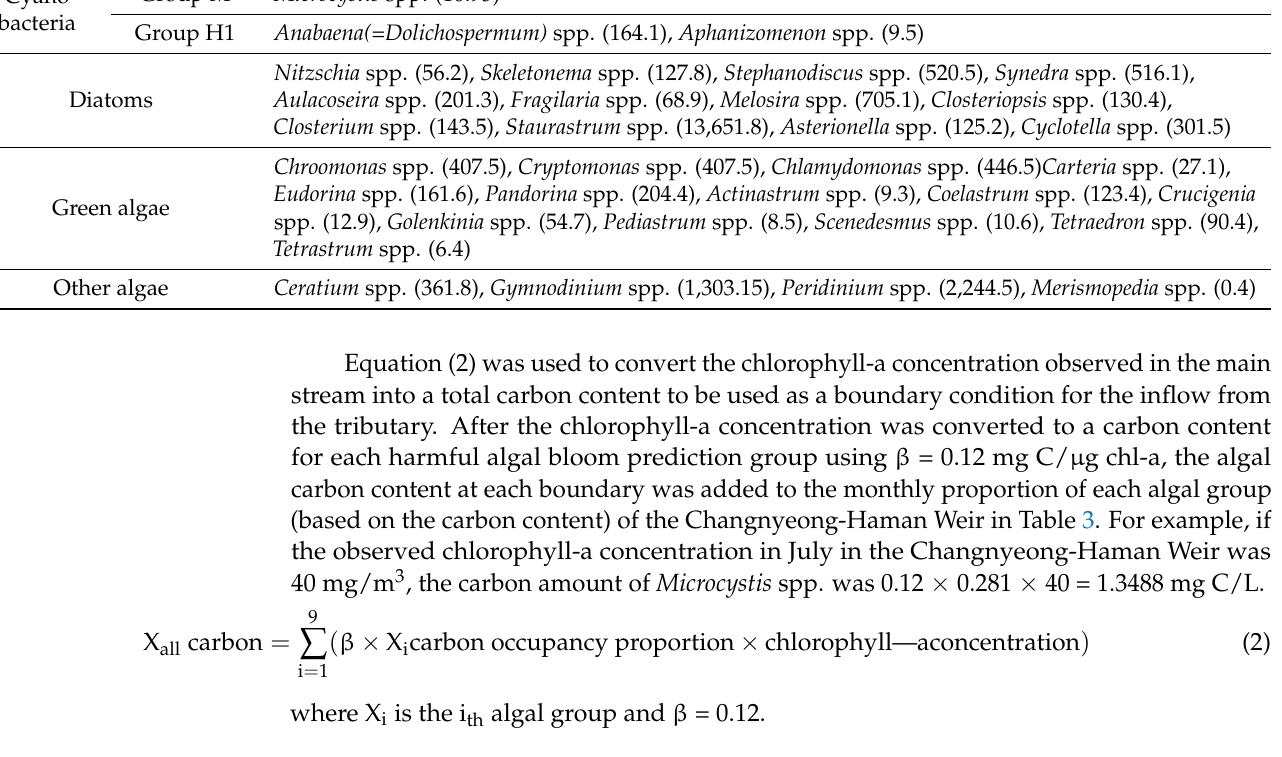
Table 3. Monthly carbon occupancy proportions (%) for each algal group in the Changnyeong-Haman Weir. Group